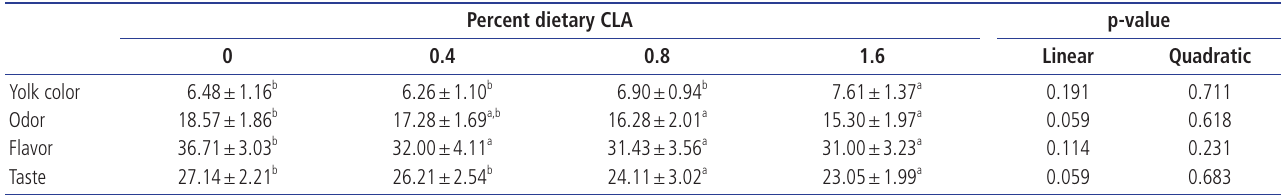
Table 5. Effects of CLA on sensory parameters of egg